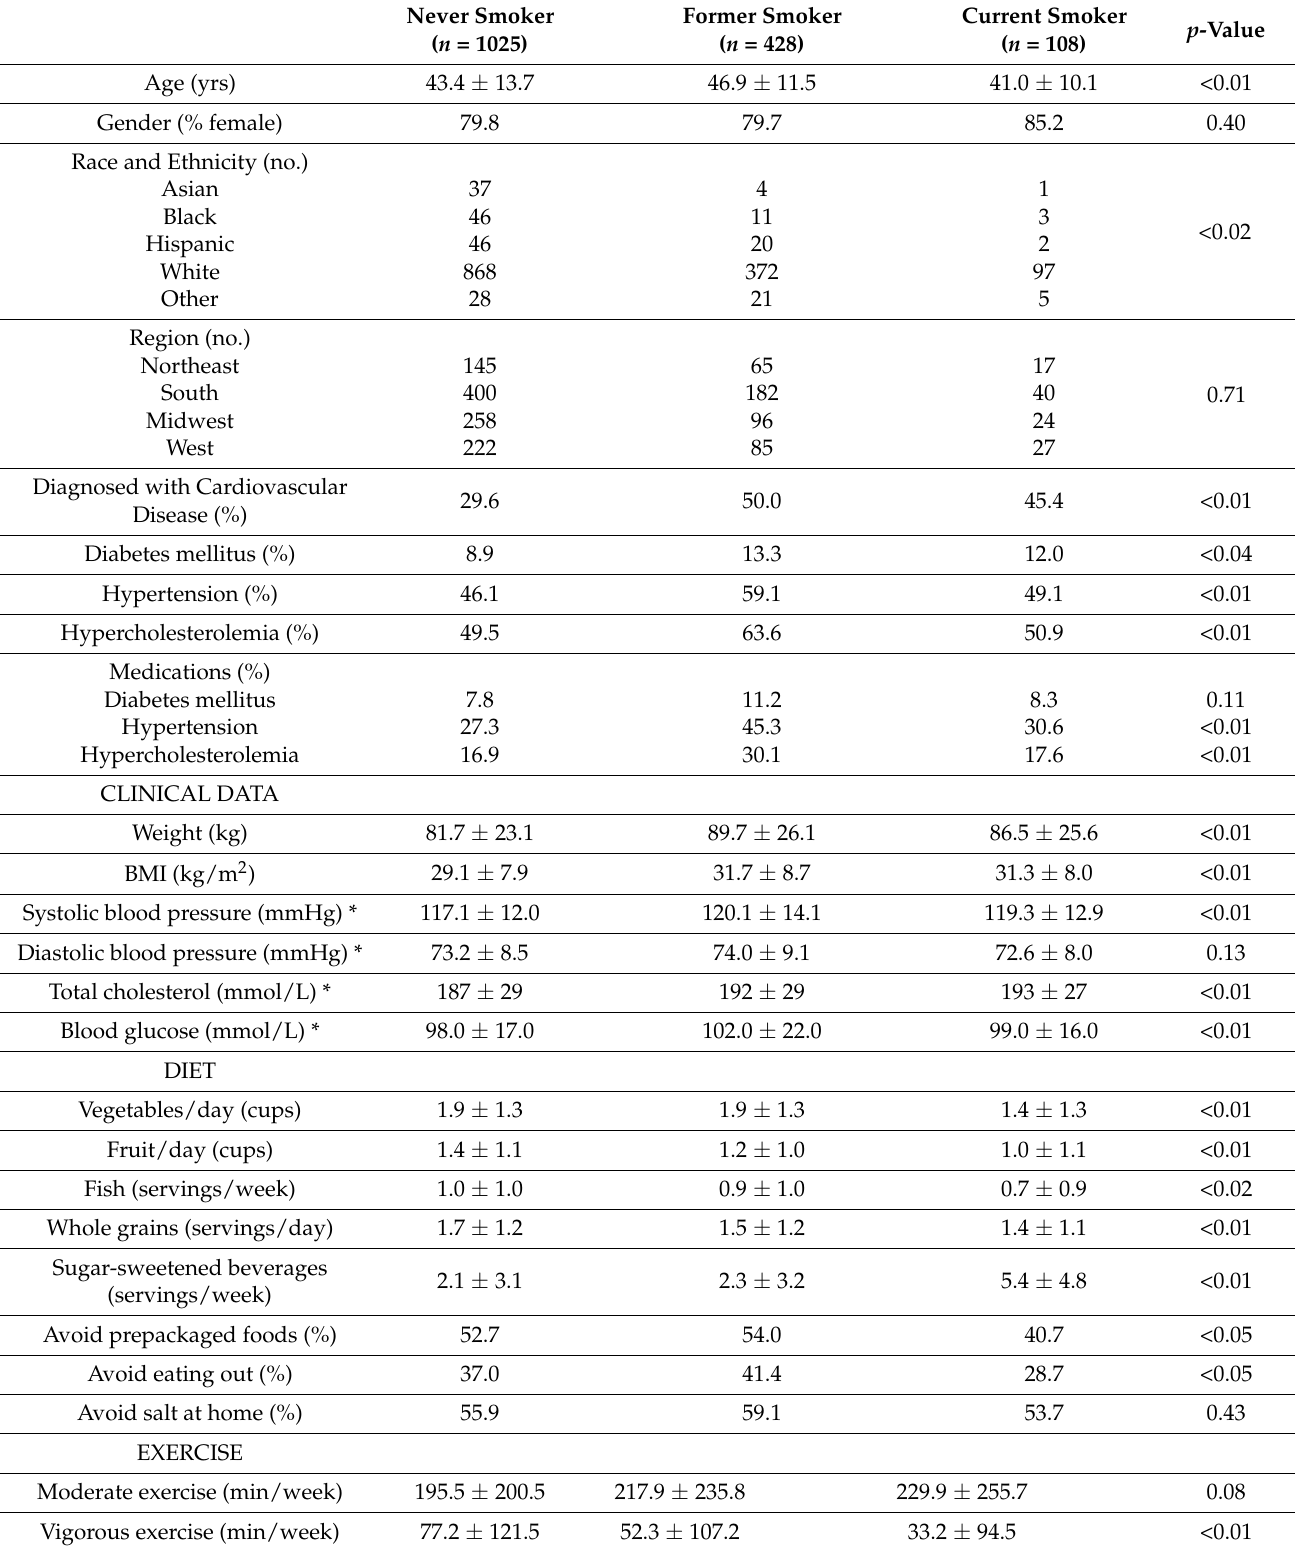
Table 1. Participant self-reported demographics and Life’s Simple 7 data by smoking